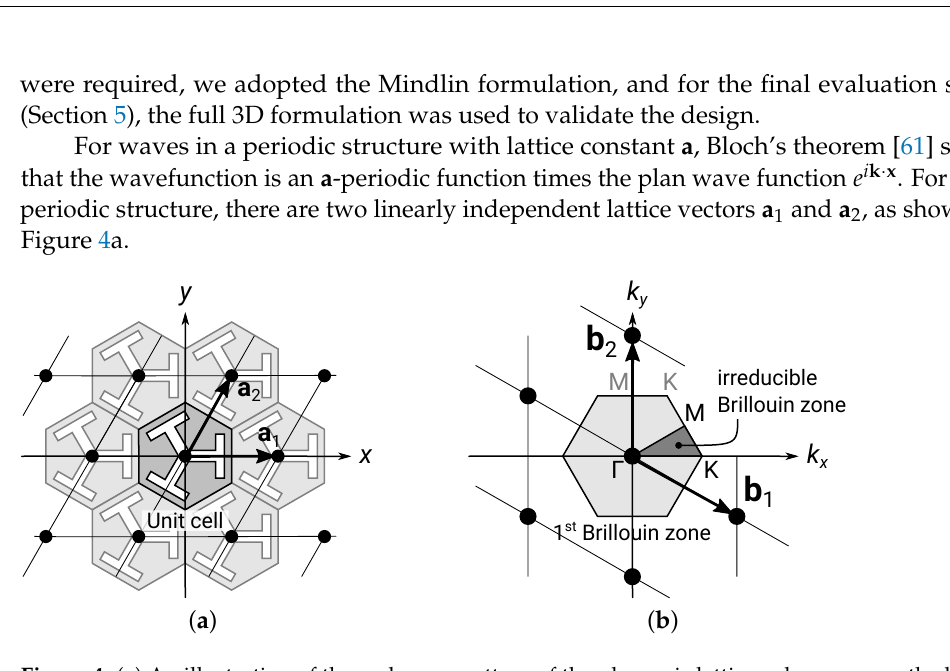
Figure 4. ( a ) An illustration of the real space pattern of the phononic lattice, where a 1,2 are the lattice vectors with (cid:107) a 1,2 (cid:107) = a the lattice constant. ( b ) The reciprocal space ( k -space) periodicity. b 1,2 are the reciprocal lattice vectors, and the primitive unit cell in k -space is the first Brillouin zone. The area bounded by Γ -K-M- Γ is the irreducible zone observing all symmetries of the